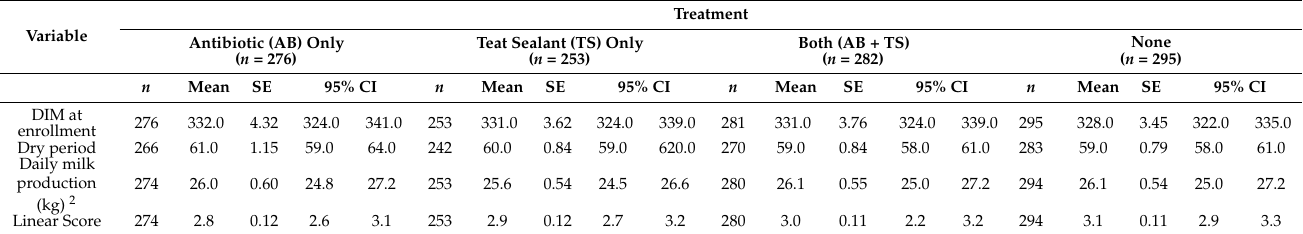
Table 1. Comparison of the continuous variable baseline traits for the enrolled dairy cows ( n = 1106 cows) from 8 herds after allocation to the four treatment groups (AB, TS, AB + TS, None) 1 . There were no significant differences between the treatment groups ( p > 0.05).